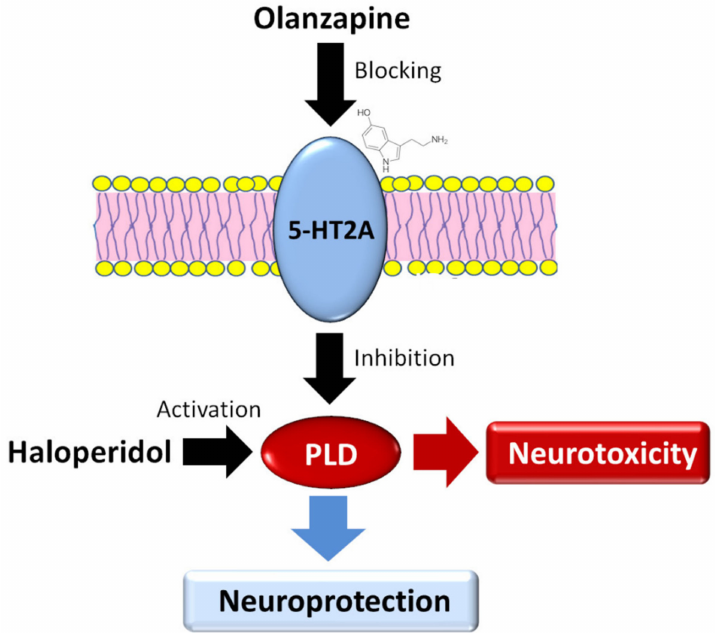
Figure 3. Proposition of a new molecular model of haloperidol neurotoxicity. Olanzapine, by blocking serotonin 2A (5-HT 2A ) receptors, reduces the activity of phospholipase D (PLD), and therefore has a neuroprotective e ff ect. In turn, haloperidol, having no e ff ect on 5-HT2A receptors, increases the activity of PLD, which may be involved in the mechanism of its